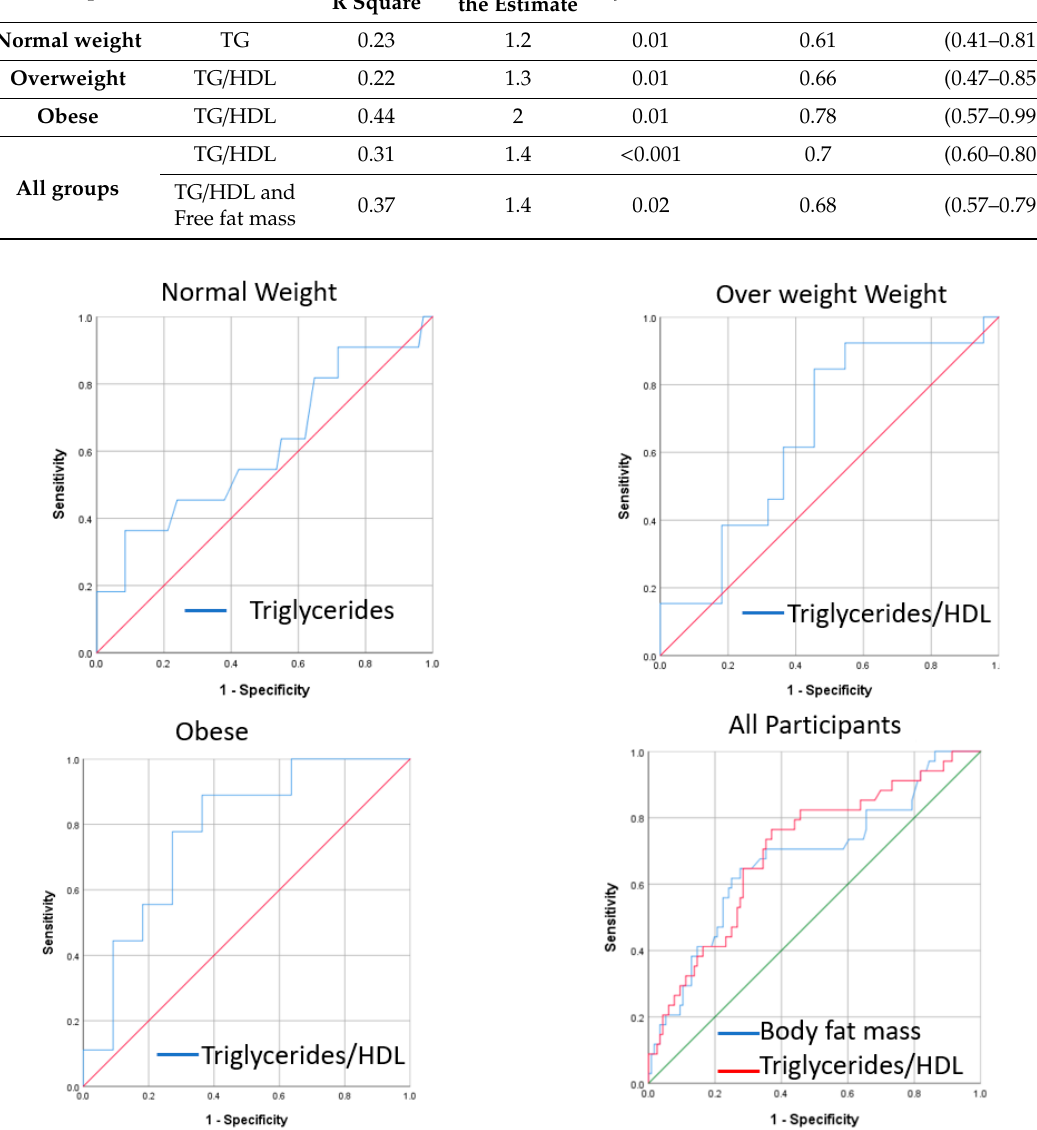
Table 4. Predictors of HOMA-IR in normal weight, overweight and obese groups by stepwise linear regression followed by the receiver operating characteristic (ROC) curve.